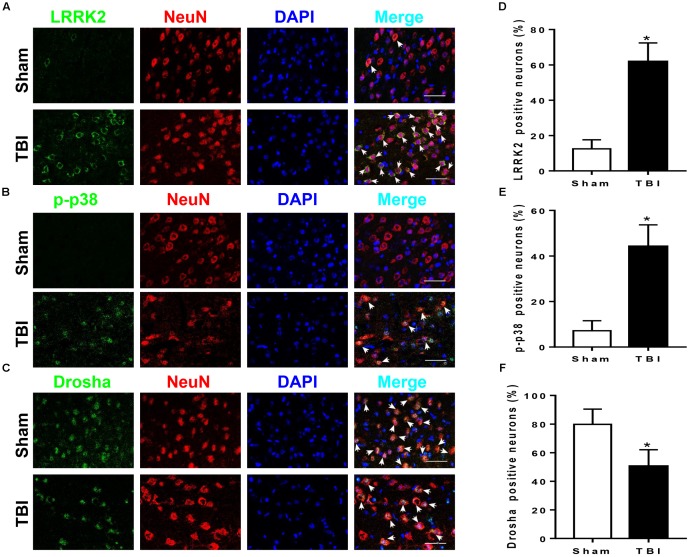
LRRK2, p38, and Drosha expression in neurons of the peri-injury cortex after TBI. Representative double-immunofluorescence staining images of LRRK2 (A), p38 (B), and Drosha (C) (green) with NeuN (red)-marked neurons to show expression profiles in the sham and 12-h TBI groups. The nuclei were fluorescently labeled with DAPI (blue). The arrows indicate the colocalization of LRRK2/p-p38/Drosha with neurons. Scale bar = 50 μm. (D–F) The percentage of LRRK2/p-p38/Drosha-positive neurons is shown. Statistical analyses were performed using Student’s t-test; data are expressed as the mean ± SD, n = 6 for each group; ∗P < 0.05 vs. sham.